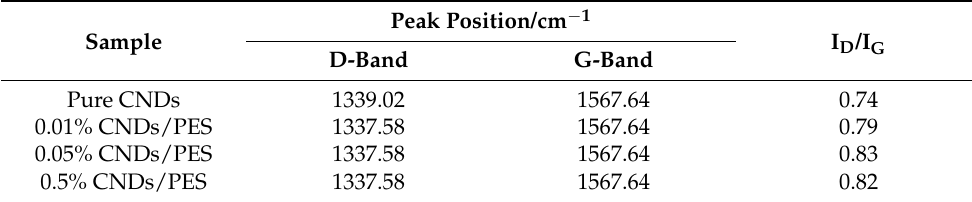
Figure 3. Characterizfation of the polyethersulfone (PES) and carbon nanodots embedded on polyethersulfone (CNDs/PES) using Raman spectra. Table 2. I D /I G ratio and carbon nanodots embedded membrane composites.